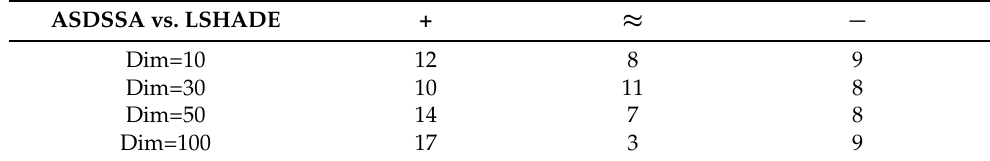
Table 8. Results of ASDSSA vs. LSHADE.